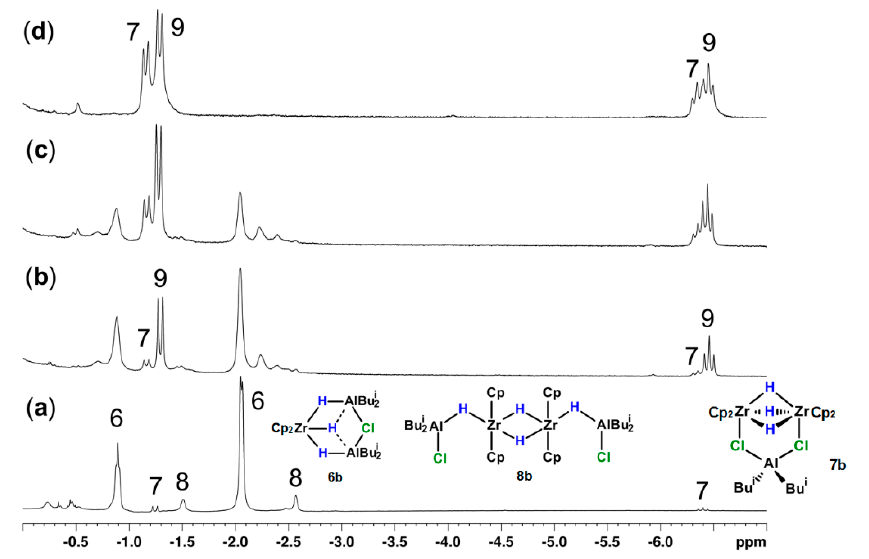
Figure 2. 1 H NMR of the [Cp 2 ZrH 2 ] 2 -ClAlEt 2 -(Ph 3 C)[ B(C 6 F 5 ) 4 ] system in С 6 D 6 (T= 299 K): ( a Figure 1. 1 H NMR of the Cp 2 ZrCl 2 -HAlBu i2 -(Ph 3 C)[B(C 6 F 5 ) 4 ] system in С 6 D 6 (T= 299 K): ( a ) Figure 1. 1 H NMR of the Cp i 2 ZrCl 2 -HAlBu 2 -(Ph 3 C)[B(C 6 F 5 ) 4 ] system in C 6 D 6 (T= 299 K): ( a )